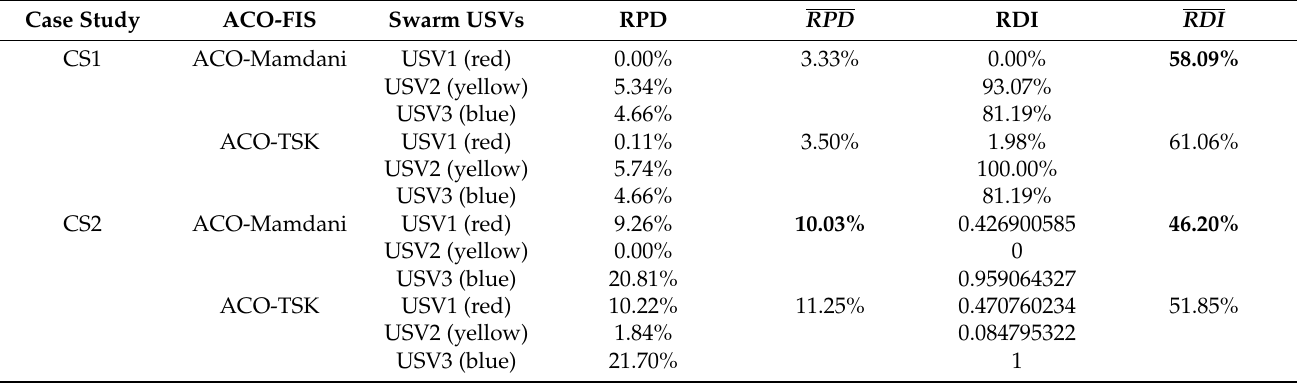
Table 5. Evaluation results of mean relative percentage deviation (RPD) and mean relative deviation index (RDI) for distance. The best solutions are denoted in